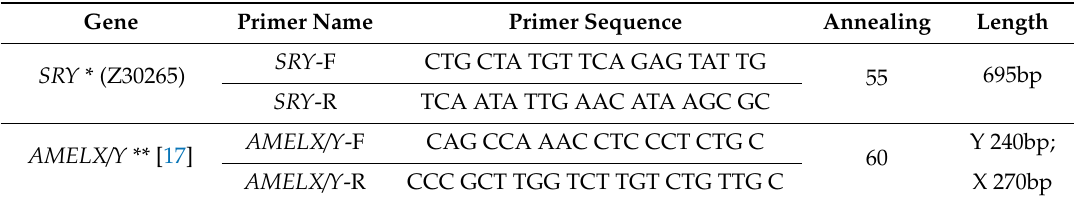
Table 1. Primers sequences, annealing temperatures and product lengths of the analysed genes.